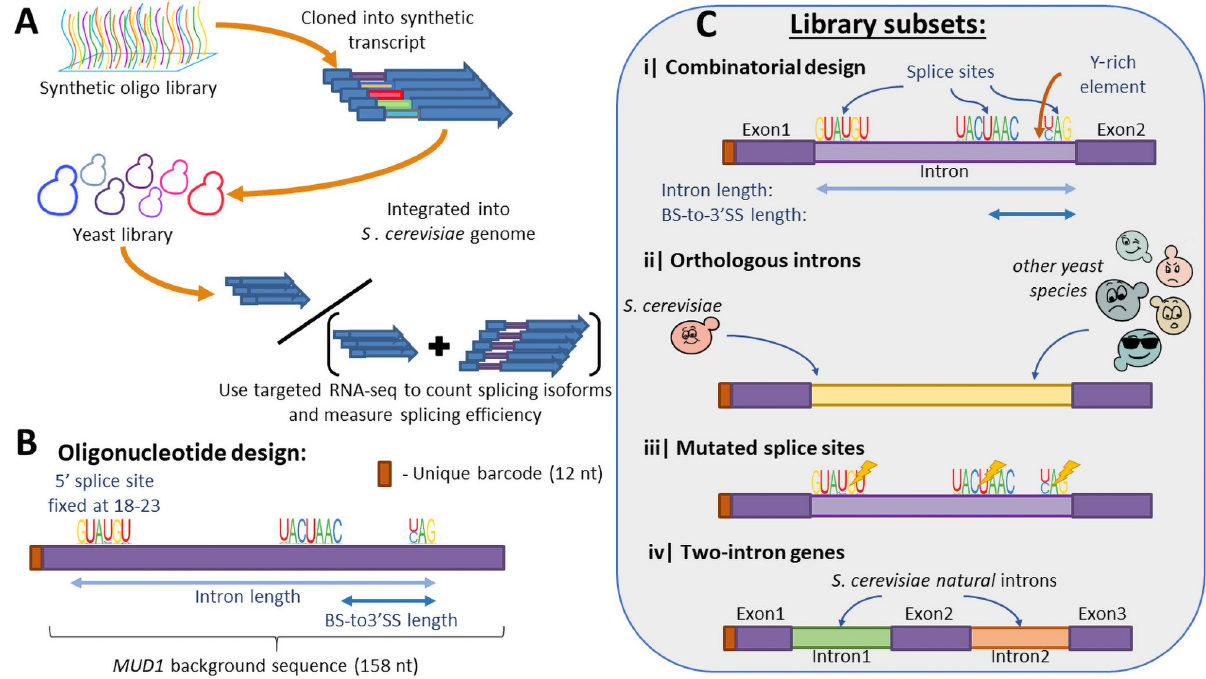
Fig 1. A designed synthetic intron library in budding yeast. A. A large oligonucleotide library of designed introns was synthesized and cloned into a synthetic gene. The gene was then integrated into the budding yeast S . cerevisiae genome, to produce a pooled yeast library. Splicing efficiency was measured using targeted RNAseq of the intronic region, identification of RNAseq reads according to a unique barcode, and of spliced isoforms using alignment of exon-intron and exon-exon junctions. B. Oligonucleotides design strategy—All oligos were identified using a unique 12nt random barcode at their 5’ end, followed by a 158 nt long design. A 5’ splice site was placed at positions 18–23 of the oligo sequence, and a branch site and 3’ splice site were placed at appropriate positions according to the choice of length parameters. C. The library was composed of four subsets—i) Synthetic introns based on a combinatorial design representing different splice site sequences and other intronic features; ii) A set of natural introns from S . cerevisiae and other 10 yeast species was introduced into the library; iii) A set of synthetic introns with random mutations introduced to the consensus splice sites; iv) A set of synthetic two-intron genes produced by pairing together short intron sequences and placing an exon between